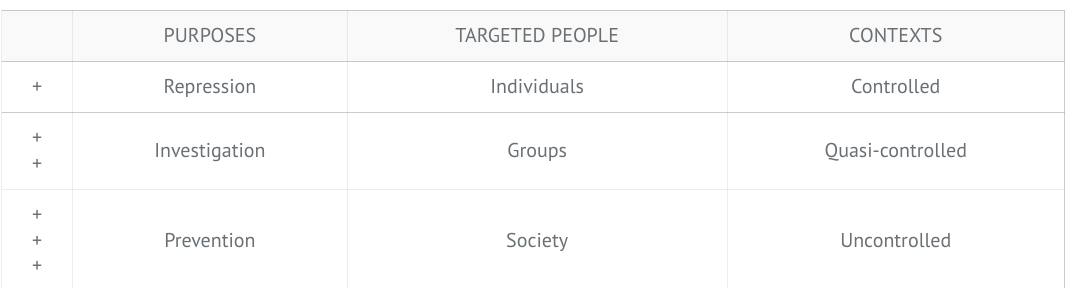
TABLE 1: Variables on the possible uses of